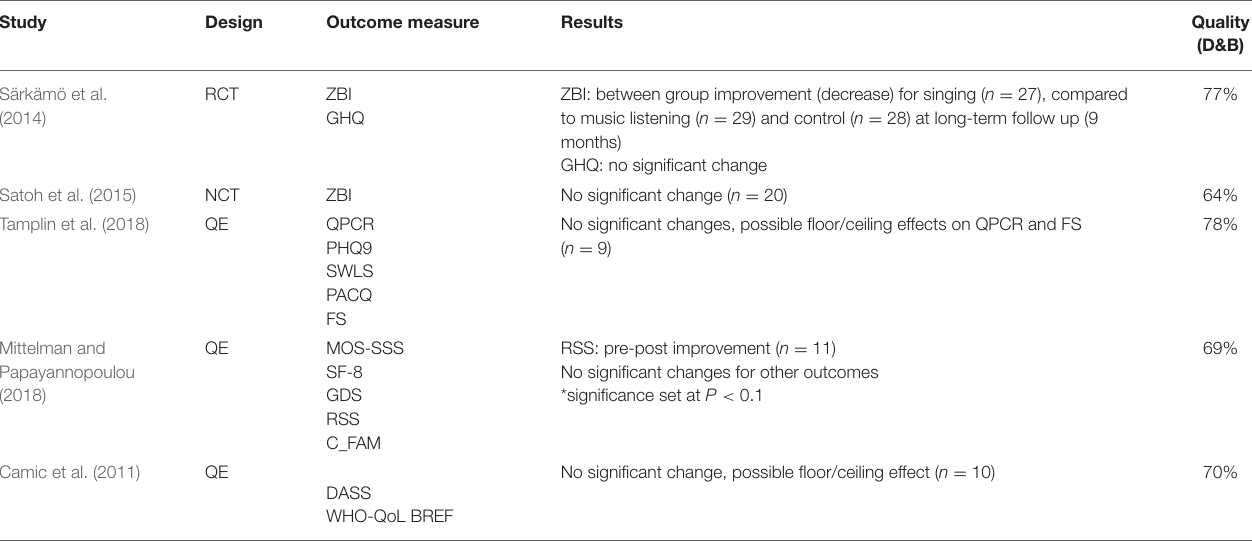
TABLE 8 | Overview of results for care-partner outcomes.